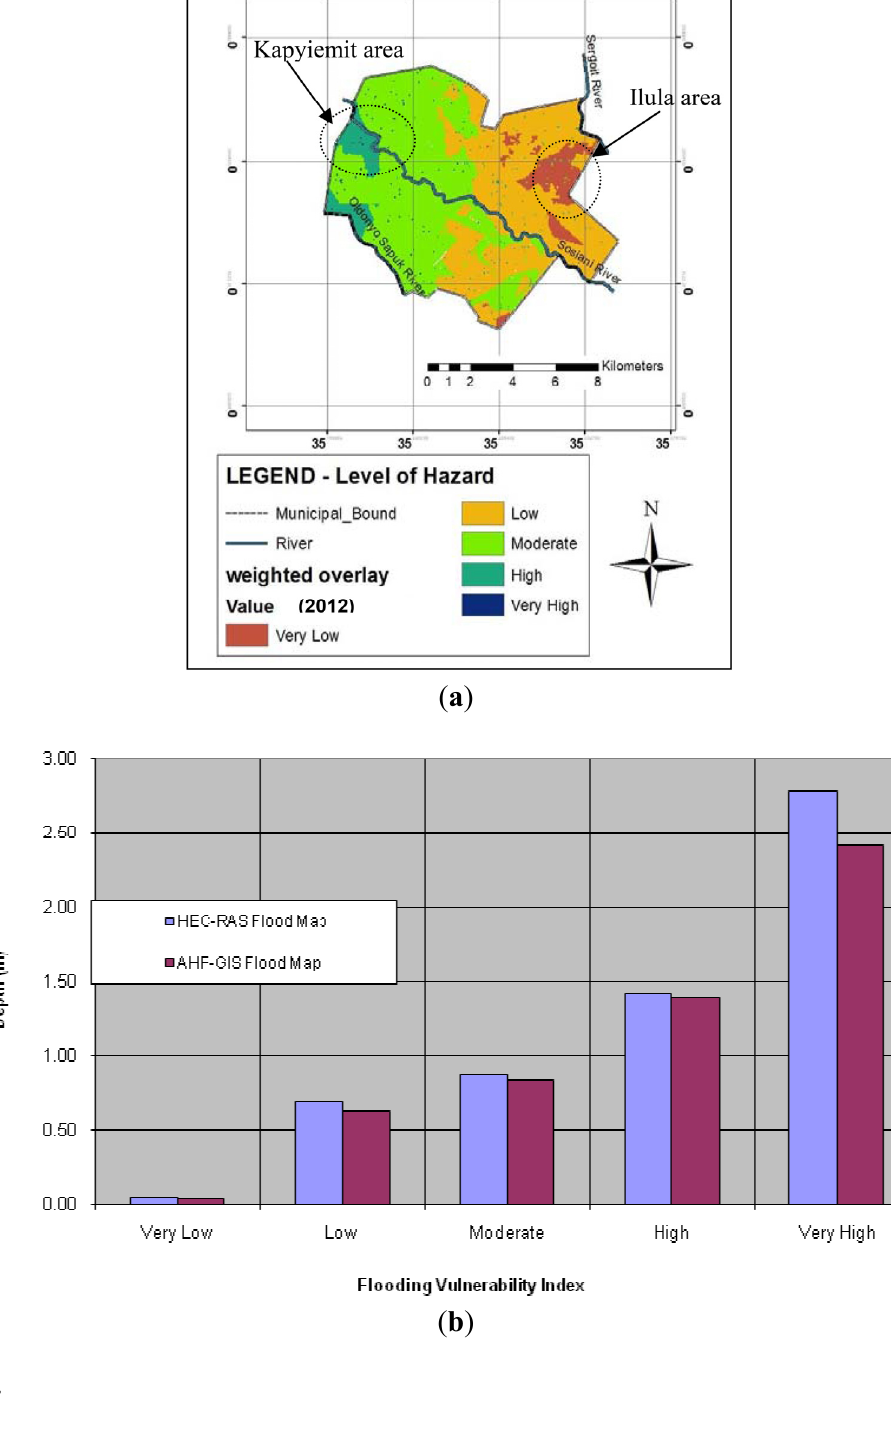
Figure 14. ( a ) Flood vulnerability validation analysis of the AHP-GIS based flood hazard results for the year 2012; ( b ) Flooding depth under each class from HEC-RAS software simulated and AHP-GIS based results in